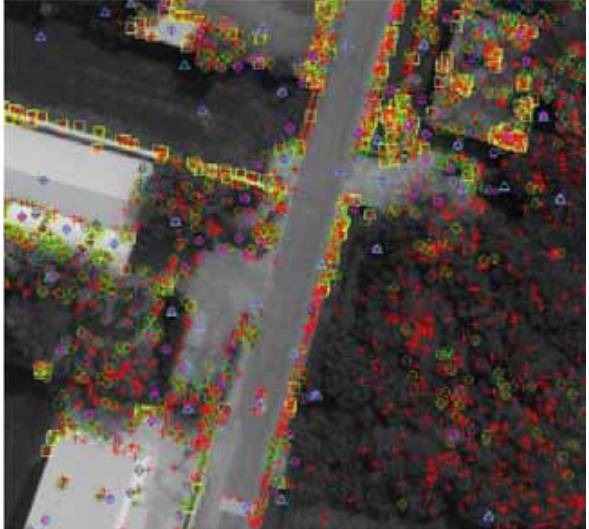
Figure 10. Location of key points after QF